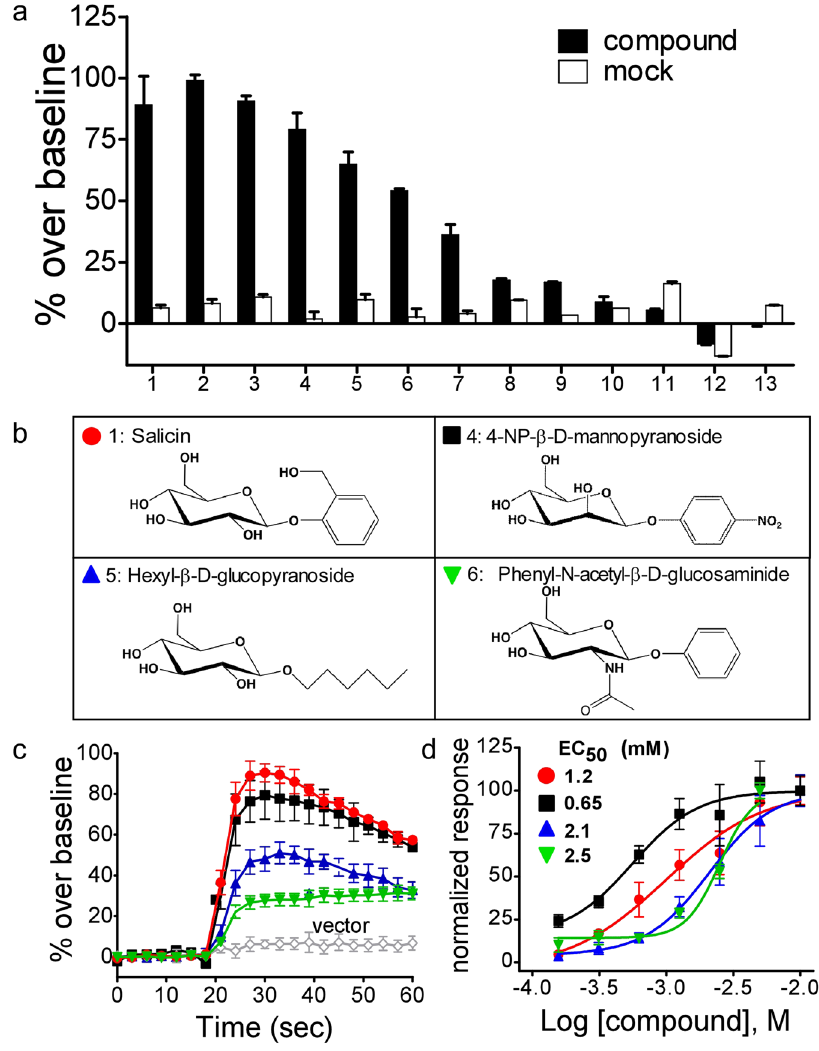
Figure 2. Identification of novel TAS2R16 agonists. ( a ) Salicin and 12 related compounds were screened at 10 mM (the highest level practical) for their ability to signal through TAS2R16. The compounds assayed were: 1, salicin; 2, phenyl- β -D-thioglucopyranoside; 3, phenyl- β -D-glucoside; 4, 4-nitrophenyl- β -D-mannopyranoside; 5, hexyl- β -D-glucoside; 6, phenyl-N-acetyl- β -D-glucosaminide; 7, sinigrin; 8, 2-naphthyl- β -D-glucopyranoside; 9, esculin; 10, methyl- β -D-glucopyranoside; 11, phenyl- α -D-glucopyranoside; 12, 1-O-phenyl- β -D-xyloside; 13, phenyl- β -D-galactopyranoside. ( b ) The structures of salicin and the three TAS2R16 agonists selected for further study. ( c ) Representative Ca 2 + flux traces after addition of salicin or selected analogs. ( d ) Dose-response curves for salicin and selected analogs. The values for each ligand were normalized to the maximum % over baseline signal (defined as 100%), to highlight the differences in EC 50 s among the ligands. The EC 50 of salicin was 1.2 mM, consistent with its reported value of 3 mM 4 . Error bars represent the standard deviation, n = 4–8 replicate